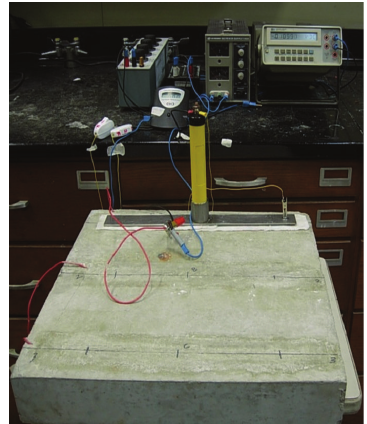
Figure 5: 𝐼 measurement using developed setup. corr